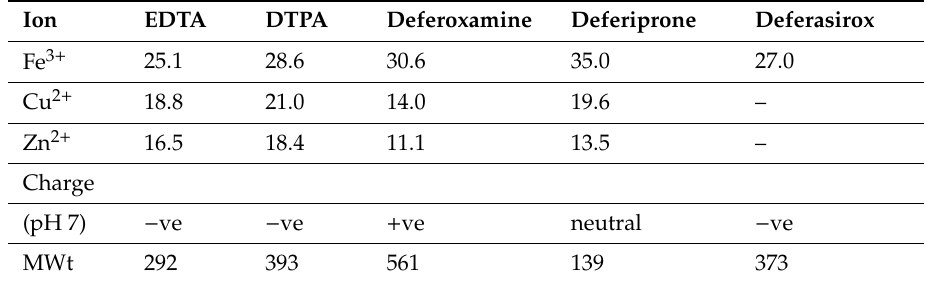
Table 3. The stability constants (log K) of essential metal ion complexes with the chelating drugs EDTA, DTPA, deferoxamine, deferiprone and deferasirox.